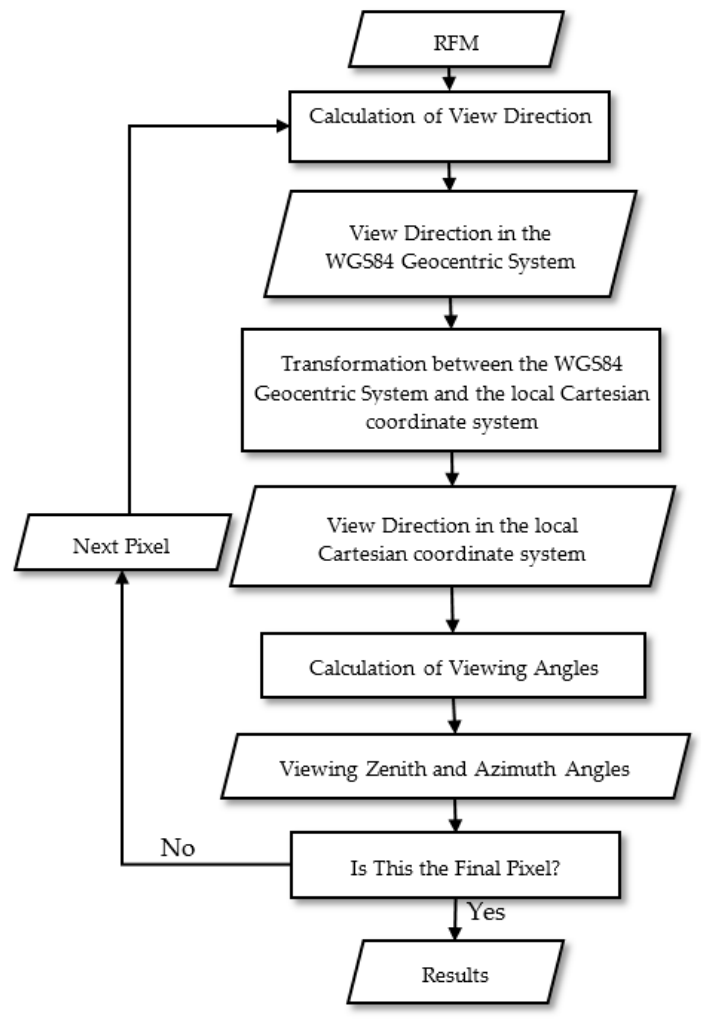
Figure 4. Calculation process for the Rigorous Sensor Model recovery.